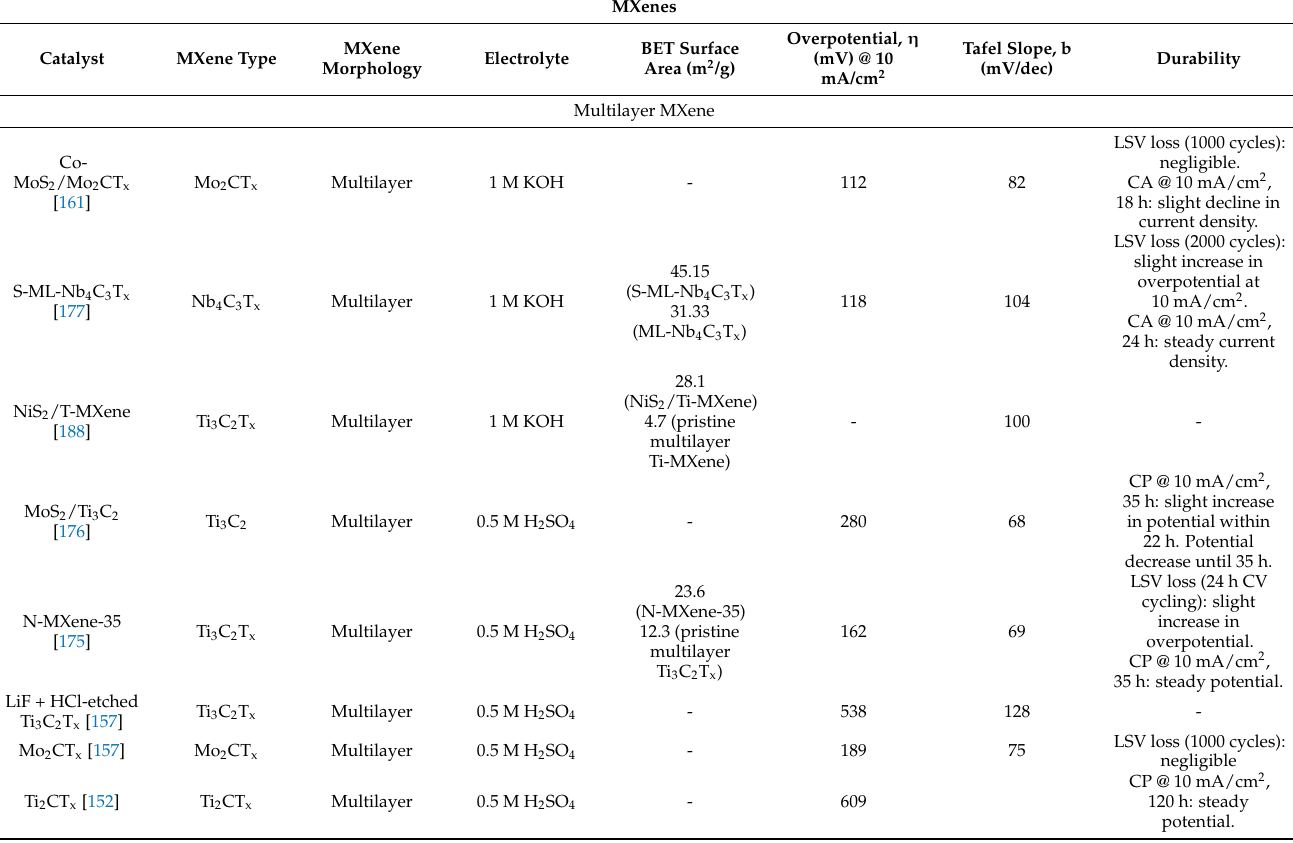
Table 3. Summary of hydrogen evolution reaction (HER) properties of MXene-based